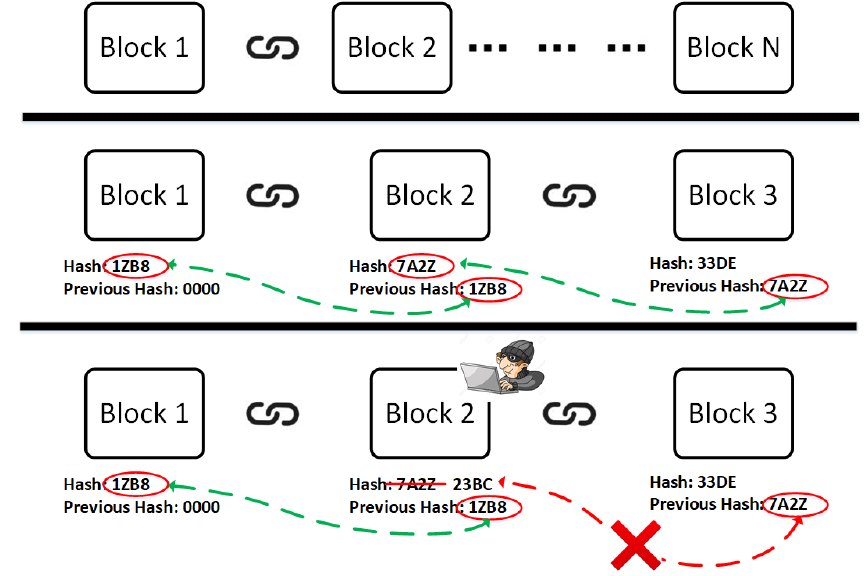
Figure 6. Underlying mechanism of i Chain